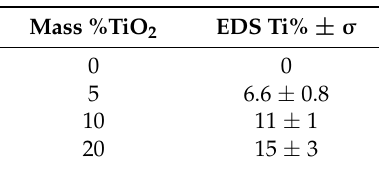
Table 1. Loading ratios determined by energy-dispersive X-ray spectroscopy (EDS). Mass percent ratios (Mass % TiO 2 ) refer to the mass of TiO 2 added to the emulsion divided by the mass of the PDMS in the emulsion during synthesis.